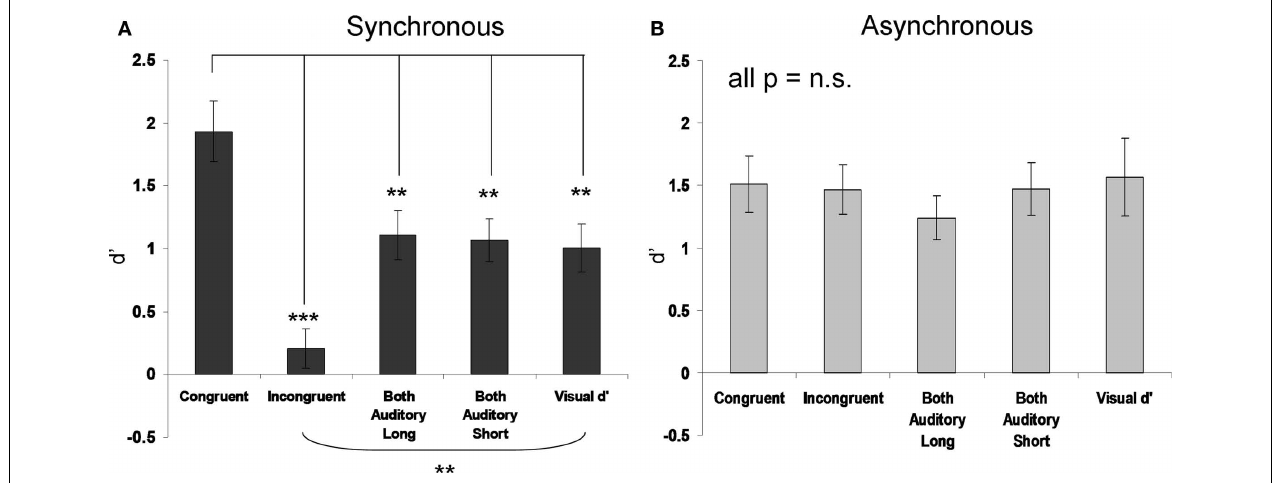
FIGURE 2 | Mean visual duration discrimination sensitivity (d (cid:2) ), SEM indicated) for each condition in Experiment 1a (A) and 1b (B). Asterisks